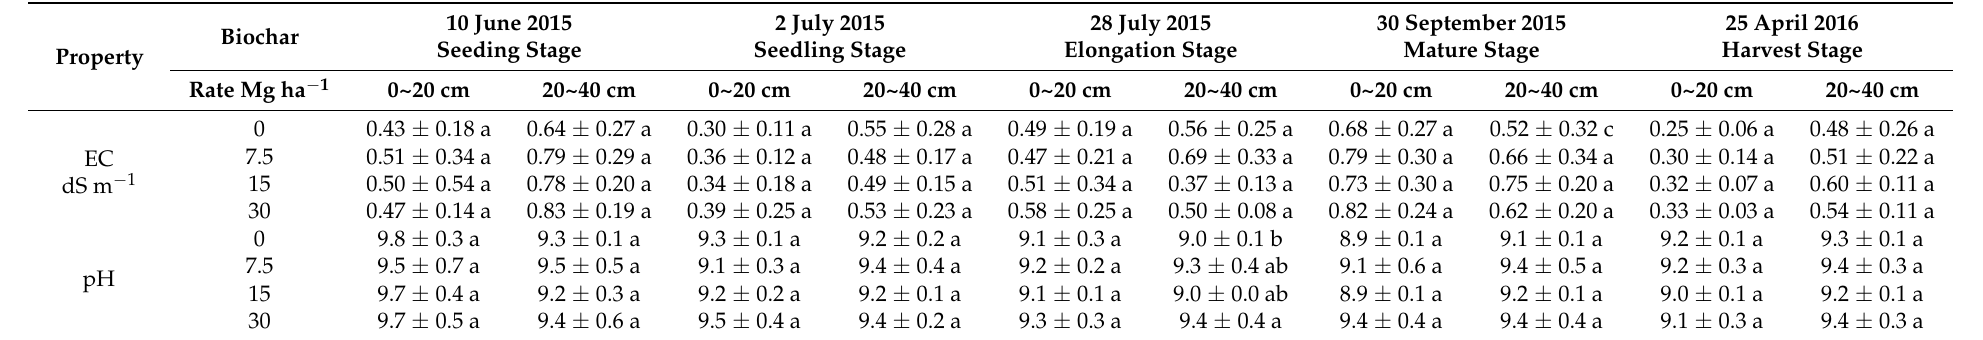
Table 3. Values of electrical conductivity (EC) and pH values of soils sampled at different points during crop cultivation. EC and pH were measured in 1: 5 w / v ratio soil